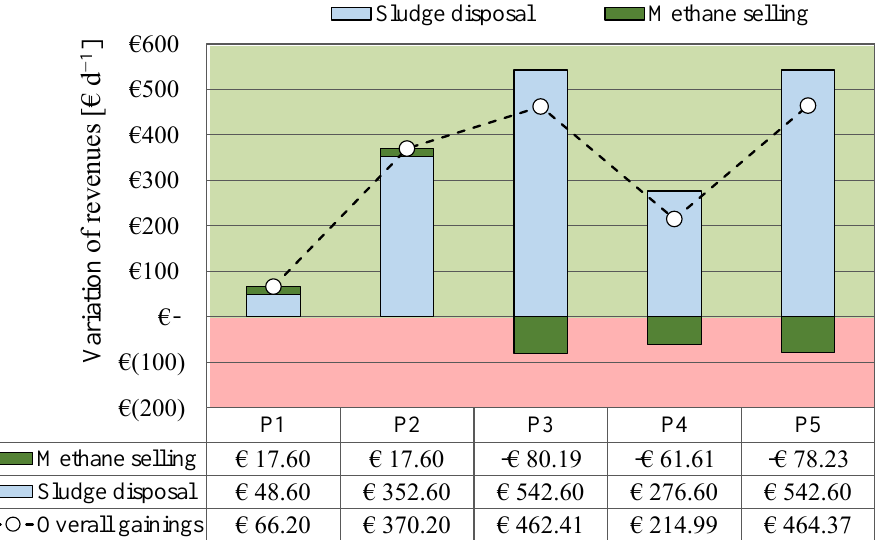
Figure 7. Overall effects of the OSA process on excess sludge minimization and methane produc- tivity during the experiment.